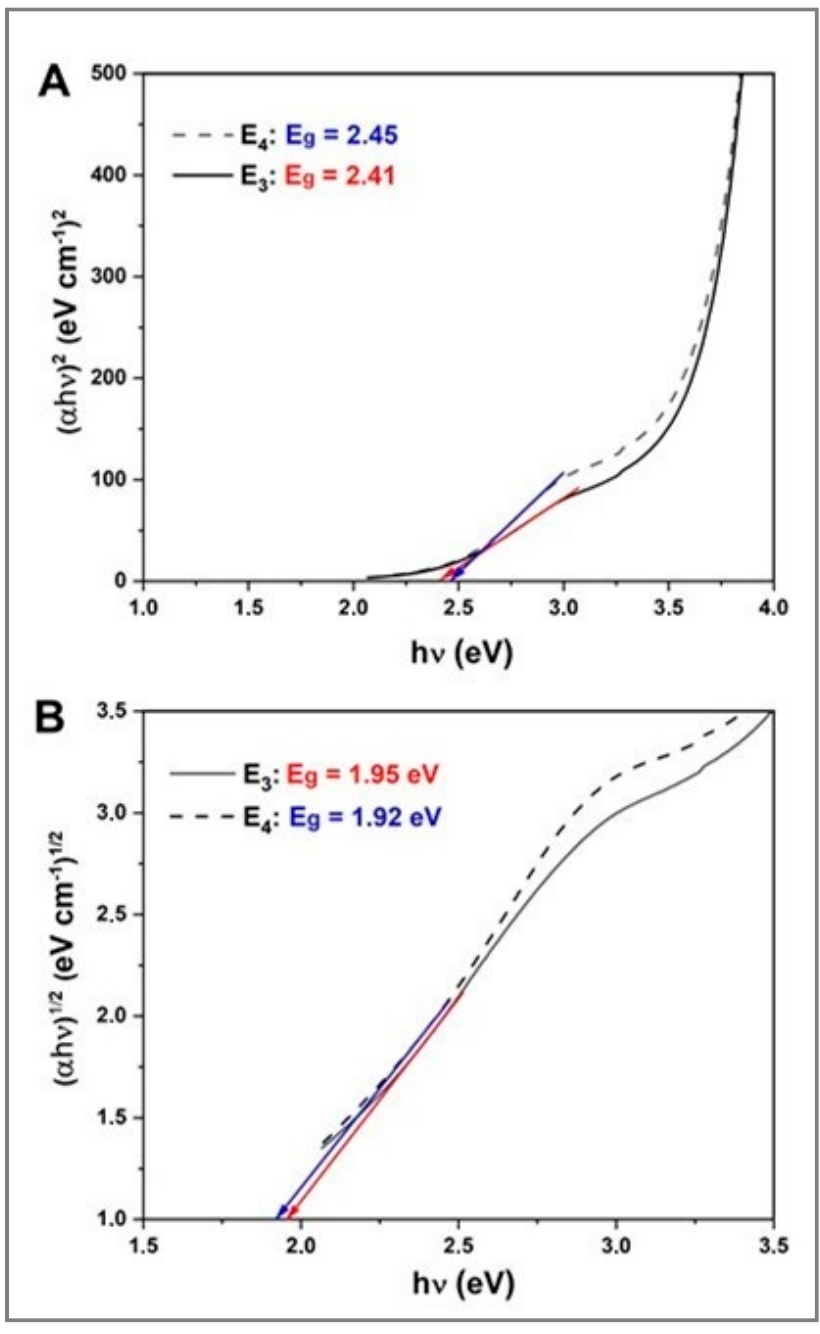
Figure 4. Tauc plot of ( α h ν ) 1/2 vs. (h ν ) of Ag 2 Se NPs obtained from the samples: ( A ) E 3 (3.4 mM [Ag + ] f , 1.7 mM [Se 4+ ] f , 20 mg mL − 1 fructose, 10 mg mL − 1 starch), and ( B ) E 4 (3.4 mM [Ag + ] f , 1.7 mM [Se 4+ ] f , 40 mg mL − 1 fructose, 10 mg mL − 1 starch).